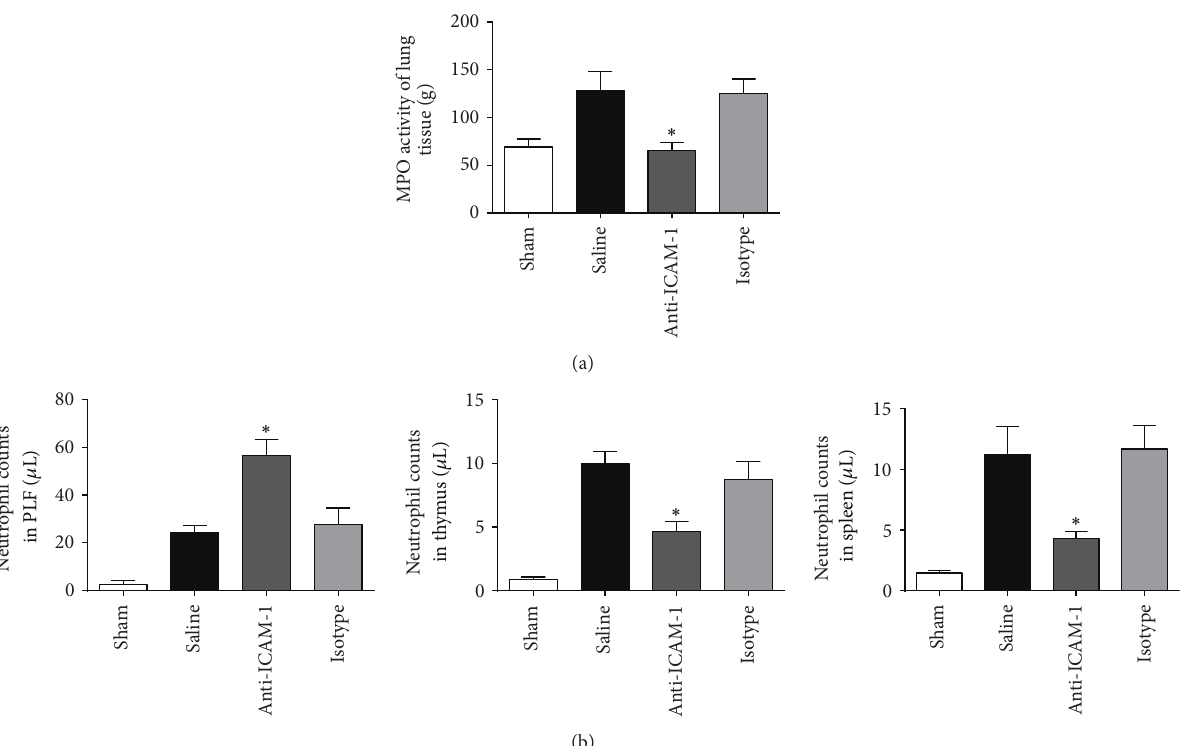
Figure 4: Anti-ICAM-1 blockade modulated neutrophils migration during sepsis. (a) MPO activity in lung homogenate was inhibited in the anti-ICAM-1 group; 𝑛 = 6 per each group. ∗ 𝑃 < 0.05 when anti-ICAM-1 antibody treated mice were compared with mice treated with isotype antibody or saline. Bars represent the median value and percentiles. (b) Neutrophil counts were elevated in PLF but reduced in thymus and spleen in the anti-ICAM-1 group compared with that in the isotype or saline groups, as demonstrated by flow cytometry. 𝑛 = 6 per each group. ∗ 𝑃 < 0.05 when anti-ICAM-1 antibody treated mice were compared with mice treated with isotype antibody or saline. Bars represent the mean ±